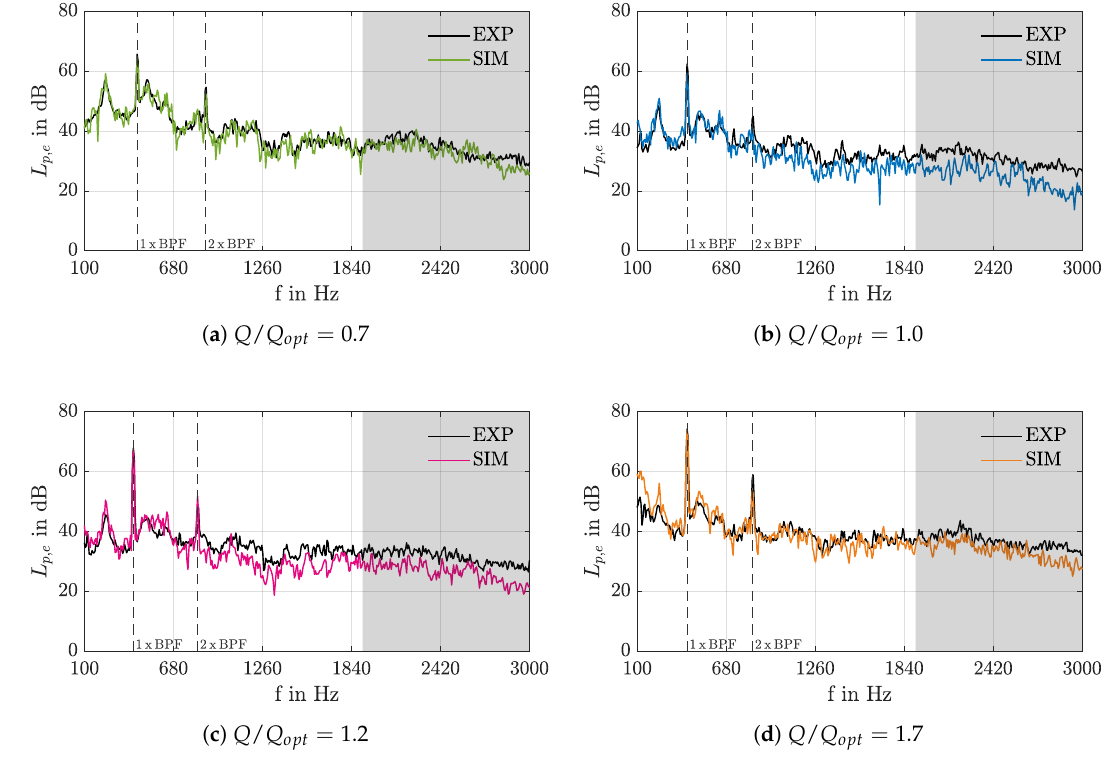
Figure 7. Acoustic spectra averaged over measurement positions M1 to M11 (shown in Figure 2a); the simulation’s cut-off frequency is marked in gray, the first (1 × BPF) and second (2 × BPF) blade passing frequency are indicated by dotted lines. BPF—blade passing